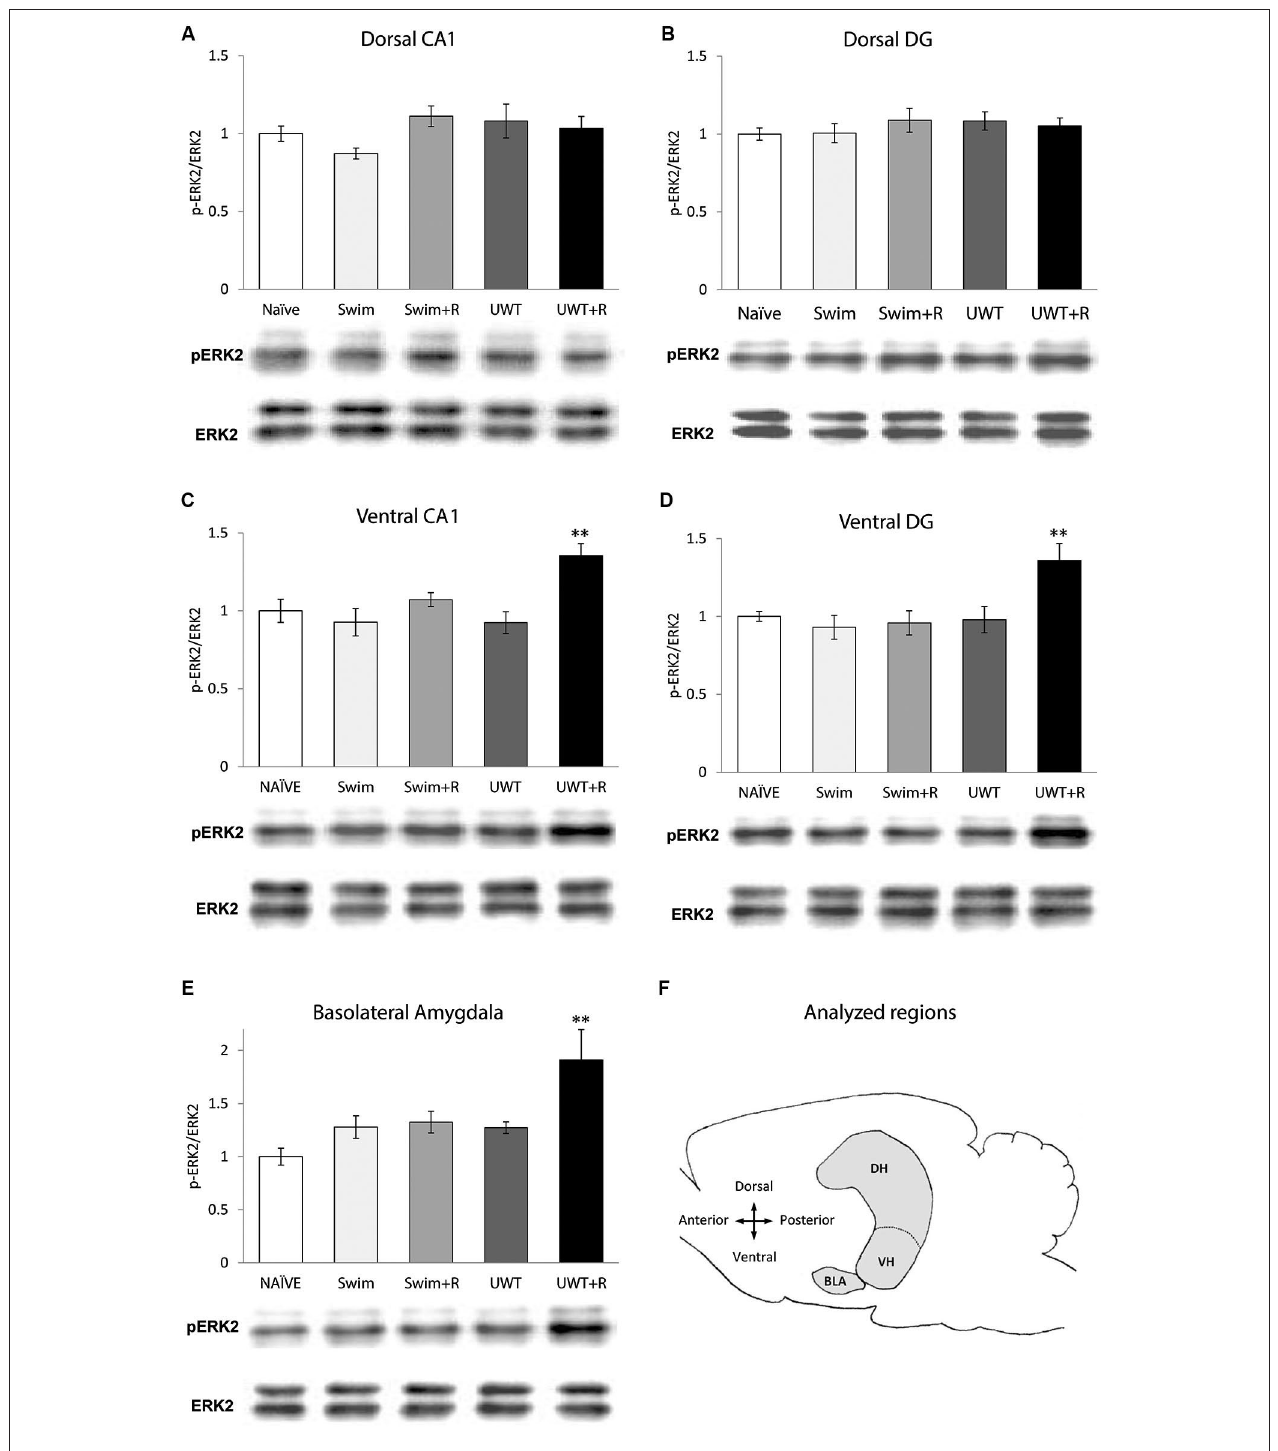
higher than the rest of the groups. (D) ERK2 activation in the ventral DG of the UWT + R group was significantly higher than the rest of the groups. (E) ERK2 activation in the BLA of the UWT + R group was significantly higher than the rest of the groups. (F) Diagram of analyzed regions. DH = dorsal hippocampus; VH = ventral hippocampus. ** p <